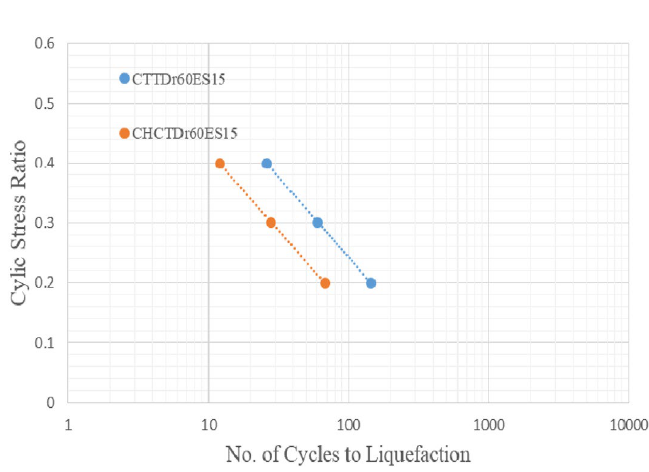
Figure 19. Stress ratio vs number of cycles to liquefaction for samples (Dr 60% FC0ES15) in CTT and